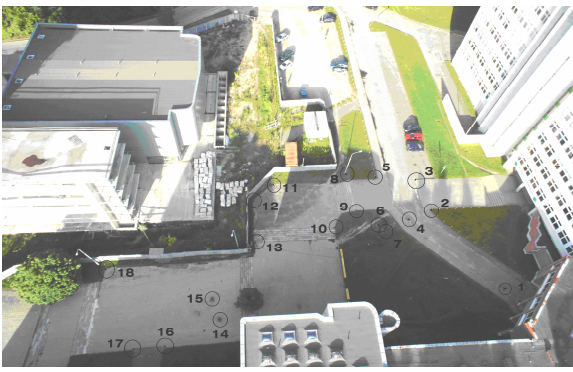
Figure 3. Distribution of ground control points in the test area